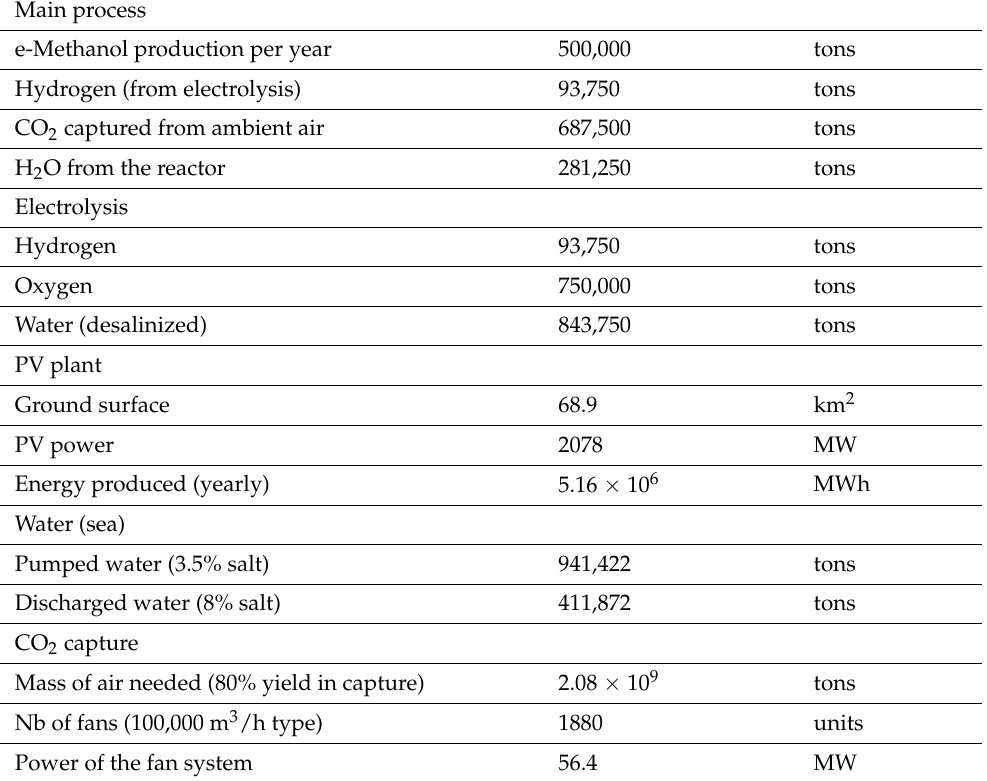
Table 3. Summary of the system parameters .